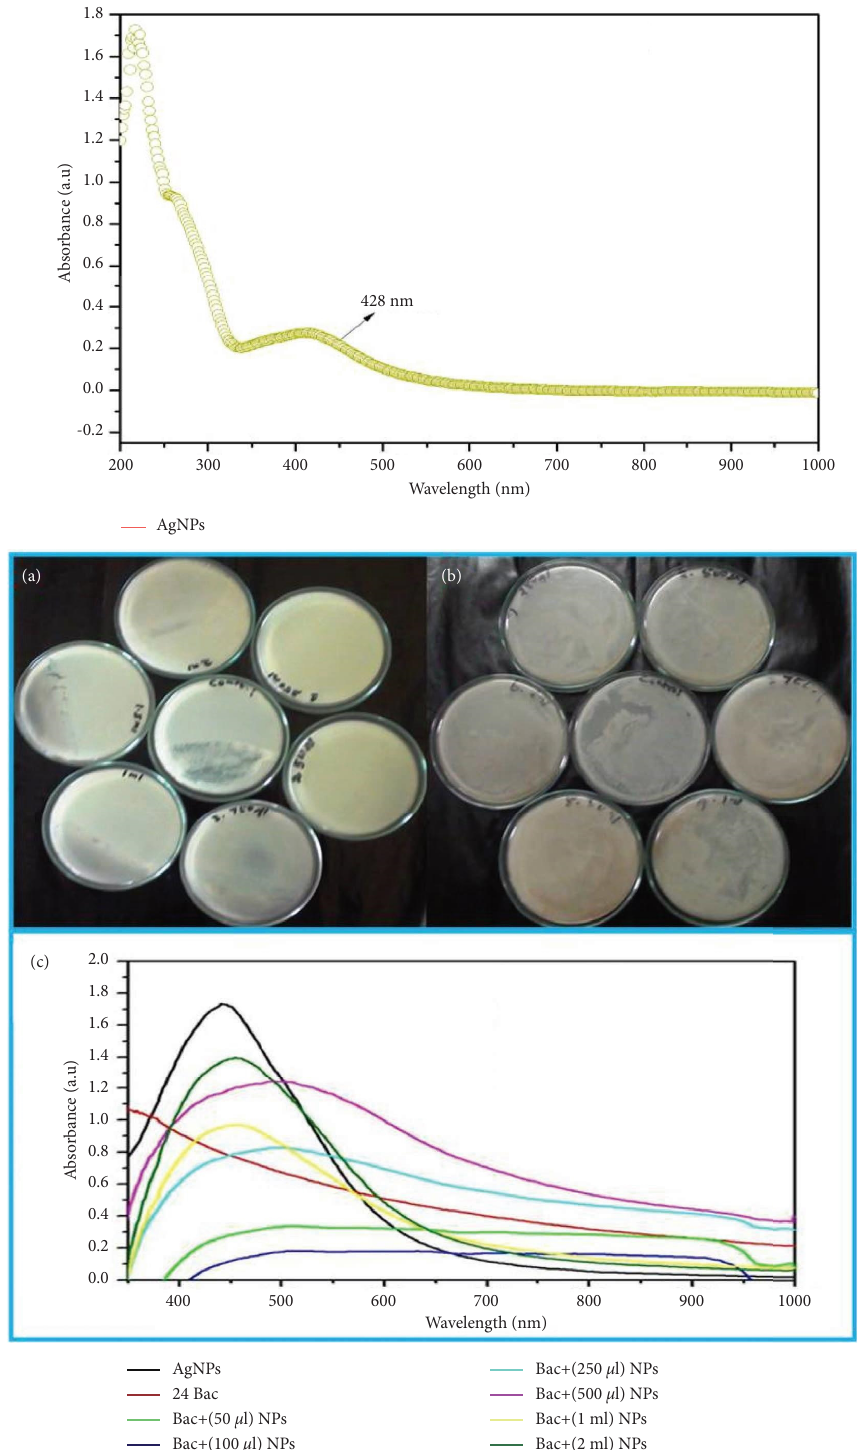
Figure 1: UV/visible spectral study of green synthesized silver nanoparticles. (a) E . coli colony formation after 2h incubation with silver nanoparticles. (b) Colony of E . coli after 24h incubation with Ag-NPs. (c) UV spectrum of 24h broth culture of E . coli with silver